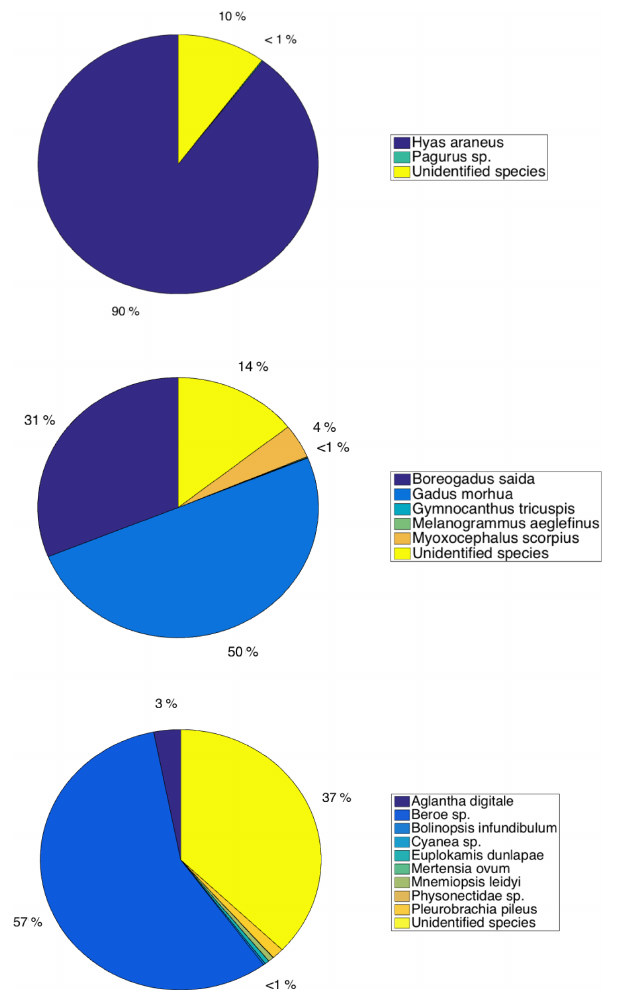
Figure 7. Percent distribution of the different species within the different biota groups. For details, see the